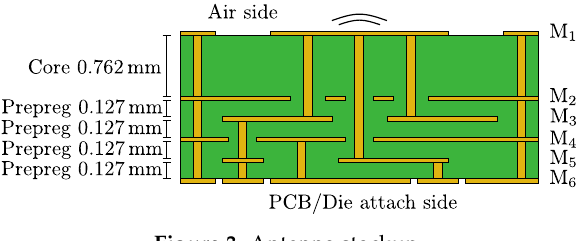
Figure 3. Antenna stackup.